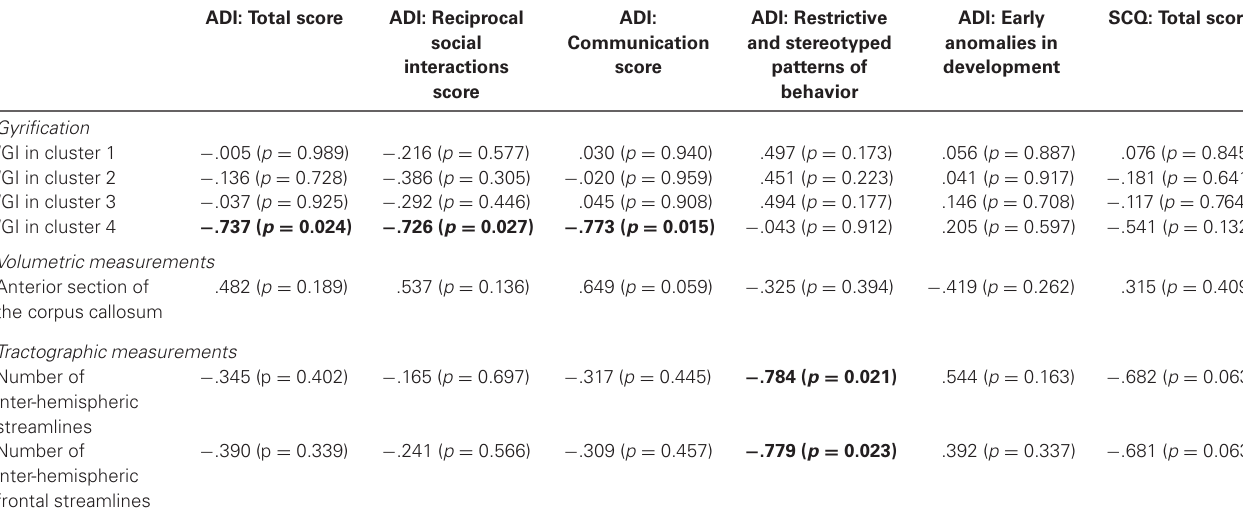
Table 1 | Correlations between clinical scores and neuroanatomical variables with between-group differences in participants with ASD .